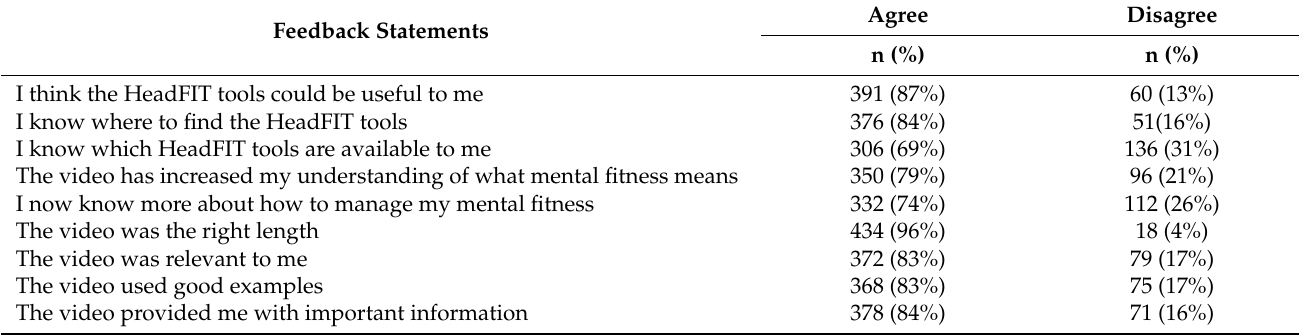
Table 3. Beneficiaries Feedback on the HeadFIT Briefing Video.